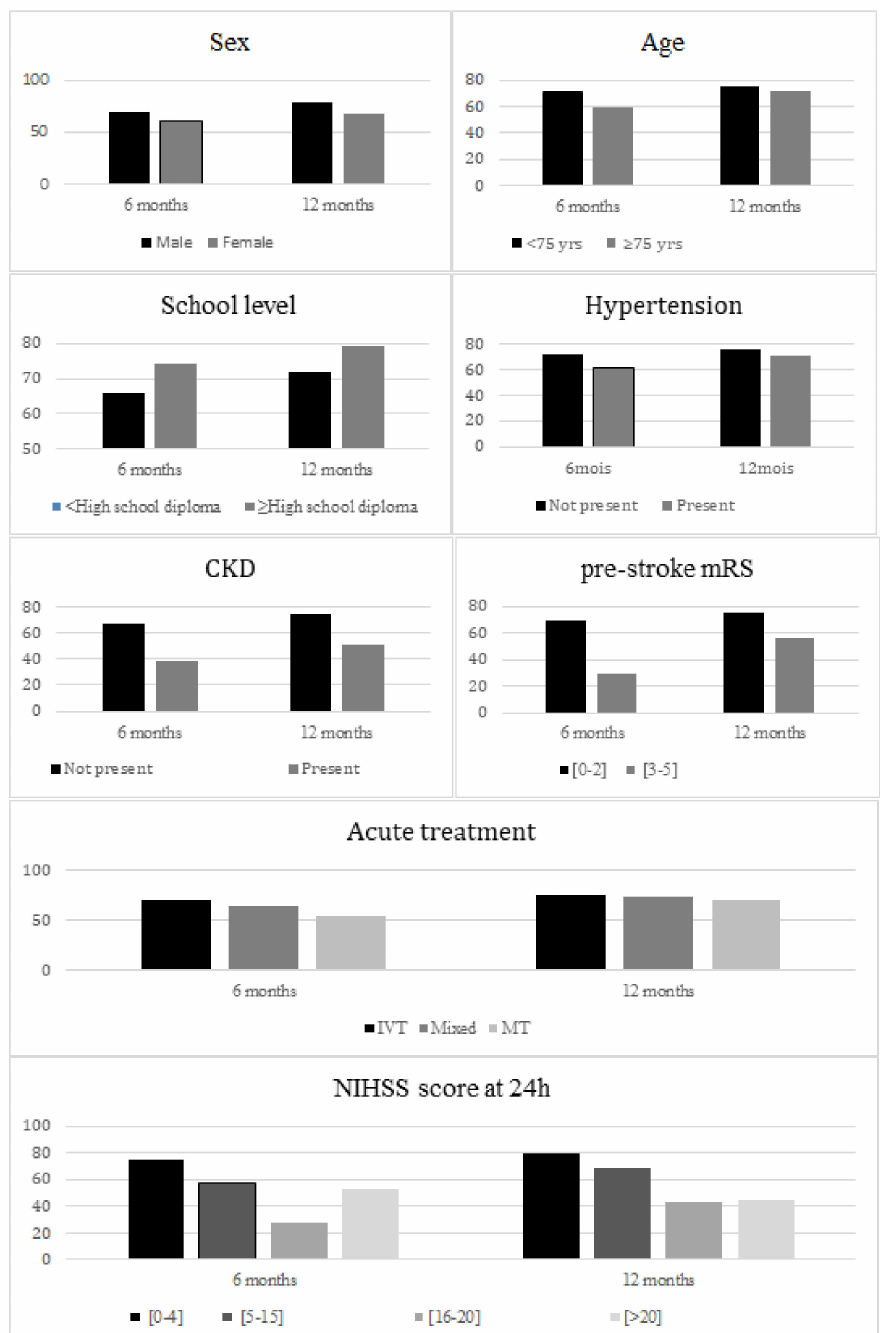
Figure 5. Mean social roles score at 6 months and 12 months according to patients’ characteristics. CKD, chronic kidney disease